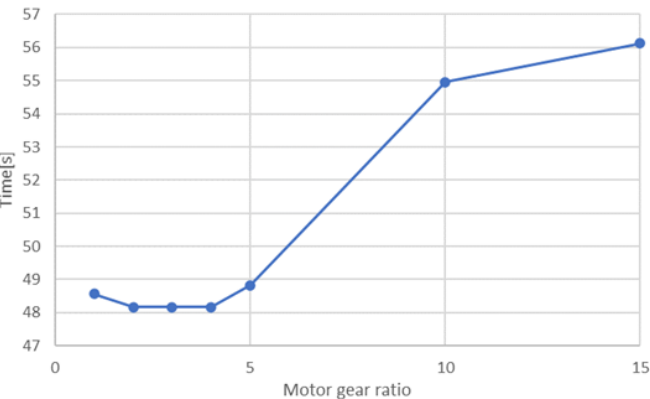
Figure 17. Relationship between electric motor gear ratio and lap time.